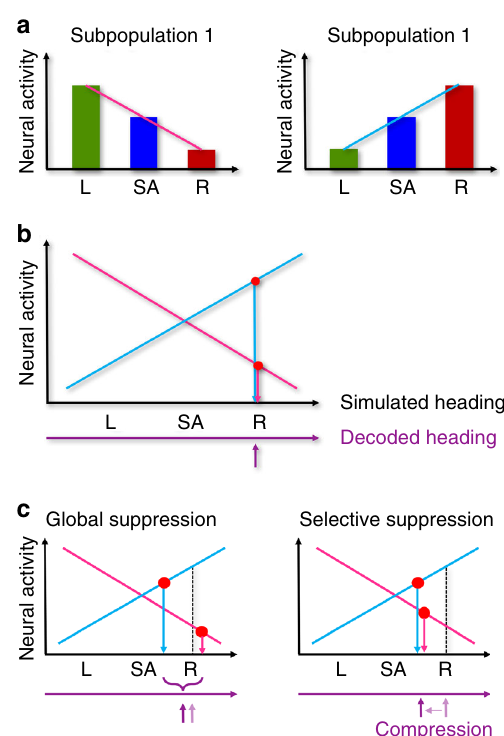
Fig. 4 Qualitative model on the role of saccadic suppression on heading decoding. a We consider a population of MST and VIP neurons to split up into two subpopulations. b During smooth eye movements both sub- populations code for the same heading (rightward in this example). c Strong perisaccadic compression as found in our neurophysiological data can be explained by selective perisaccadic suppression of stimulus driven responses (right panel), but not by global suppression of activity (left panel). For details see